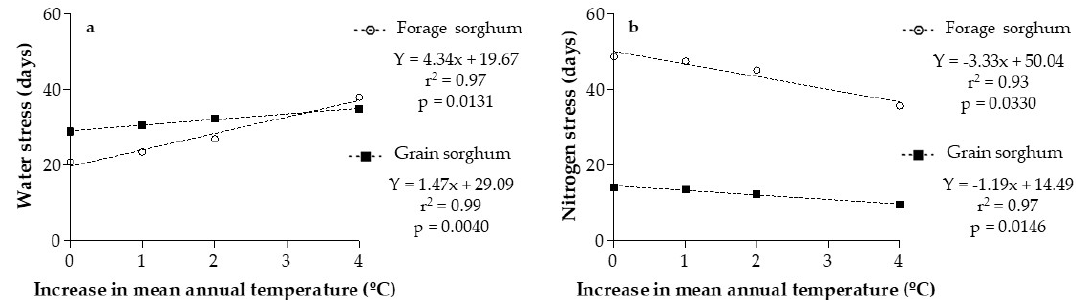
Figure 4. Average days of ( a ) water and ( b ) nitrogen stress during the growth cycle of forage and grain sorghum under scenarios with increases in the mean annual temperature.